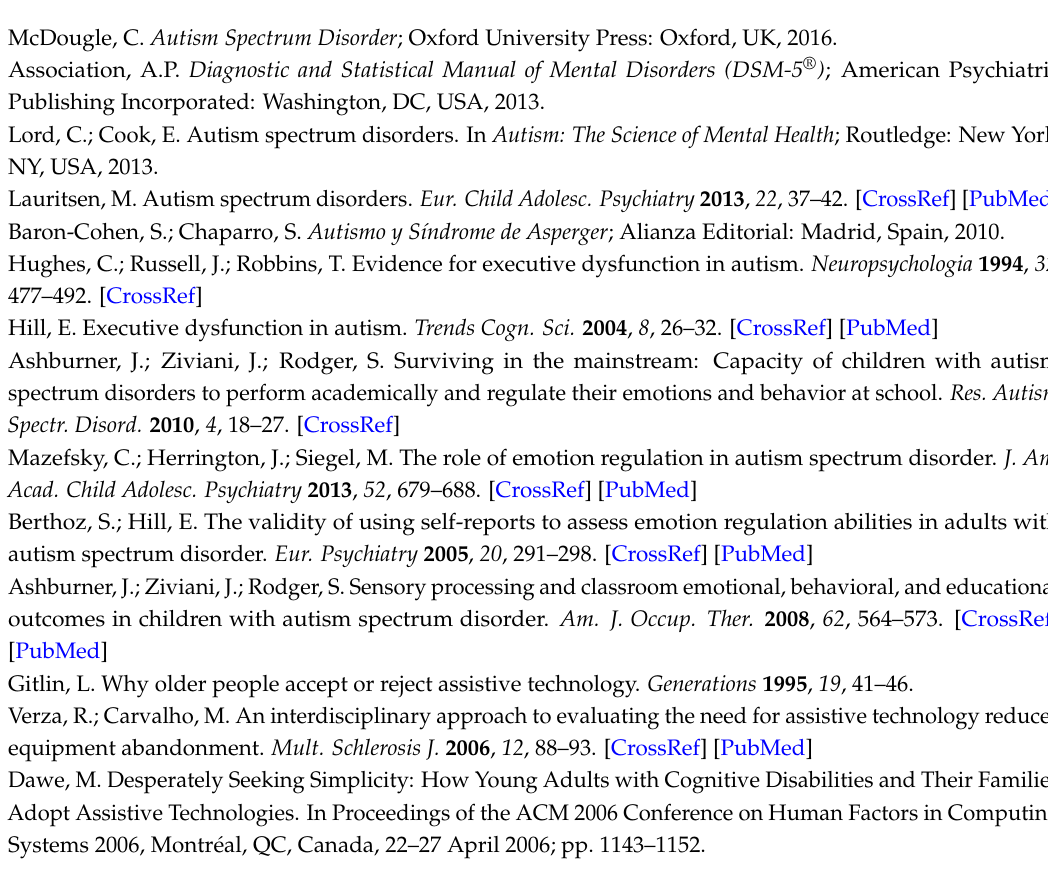
1. Classmate yells, and gets frightened of it. Follows the strategy. Keeps the bubbles on the screen for a while. Finishes the strategy. 2. On two occasions, seeks the caregiver’s attention and points to the watch. Seems to be engaged with the bubbles.